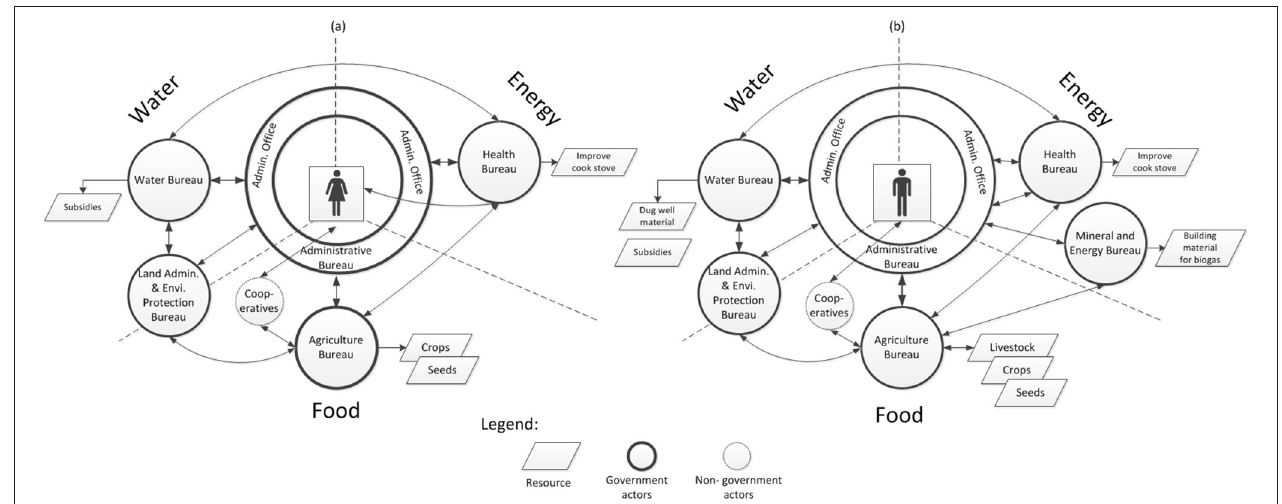
FIGURE 2 | Graphical representation of actors identified by female-only (a) and male-only groups (b) .